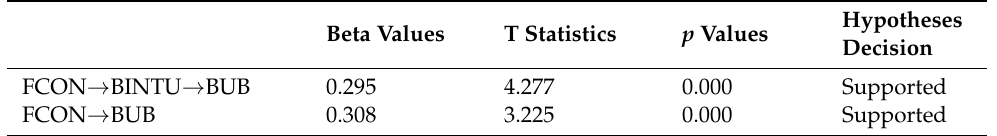
Table 9. Results of indirect